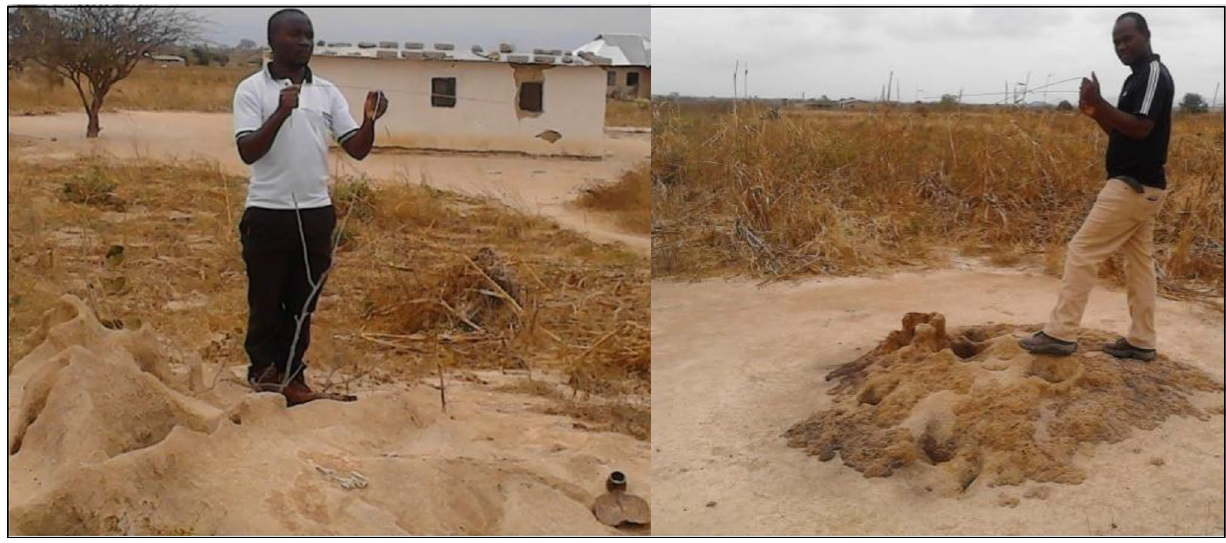
Fig. 5 Dowsing rods crossing on top of termite’s mounds in Mtumba suburb indicating a closer water table, locals have trapped this technology to successfully explore and dig deeper